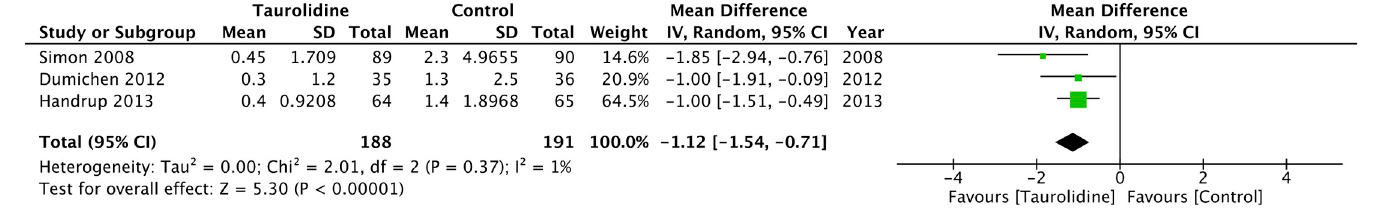
PLOS ONE | https://doi.org/10.1371/journal.pone.0231110 April 7,